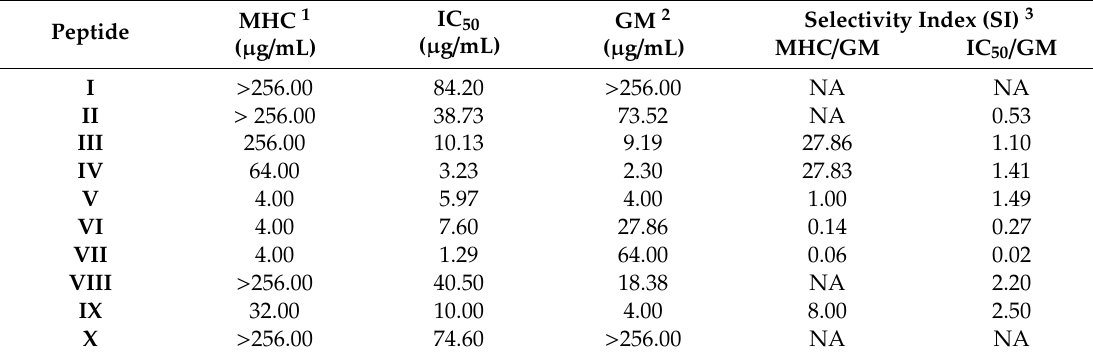
Table 5. MHC, IC 50 , GM and selectivity indices (SI) of peptides determined for reference strains of S.